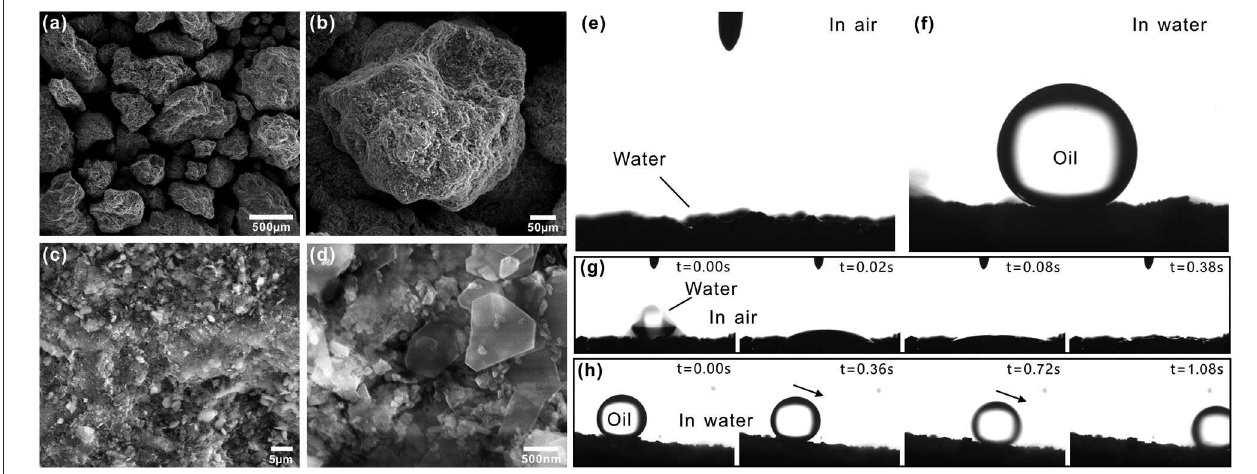
FIGURE 2 | Surface morphology and wettability of the zeolite layer. (a–d) SEM images of the zeolite particles. (e) Water droplet on the zeolite particles in air. (f) Oil droplet on the zeolite particles in water. (g) Process of a small water droplet being absorbed by the layer of zeolite particles. (h) Underwater oil droplet rolling on the layer of zeolite particles.